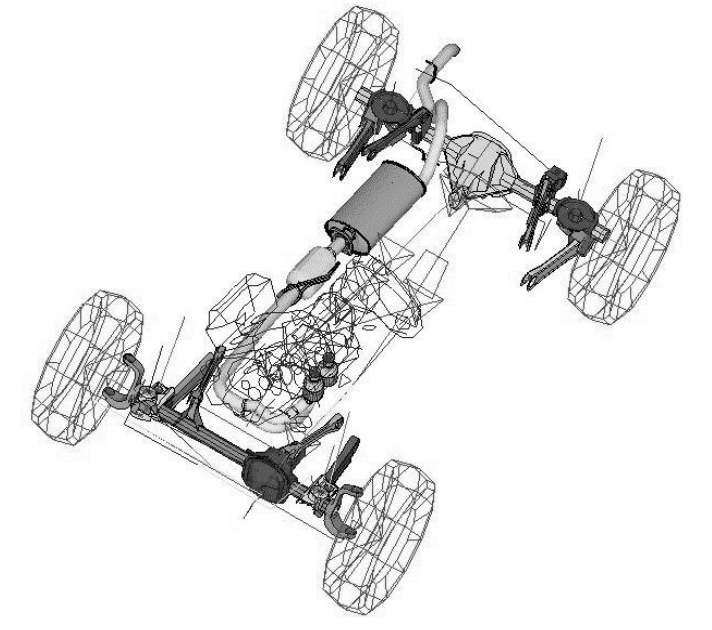
Fig. 2. Driveline, powertrain, and exhaust system of a 4WD Sport Utility